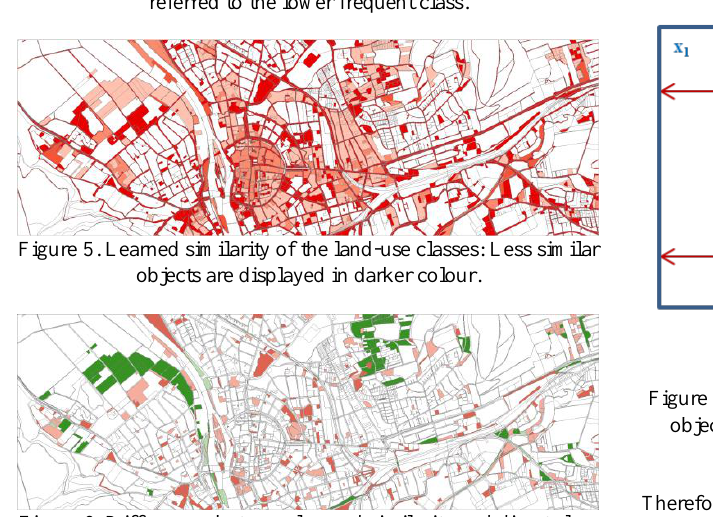
Figure 6. Differences between learned similarity and direct class comparison (green/red – feature similarity higher/lower)